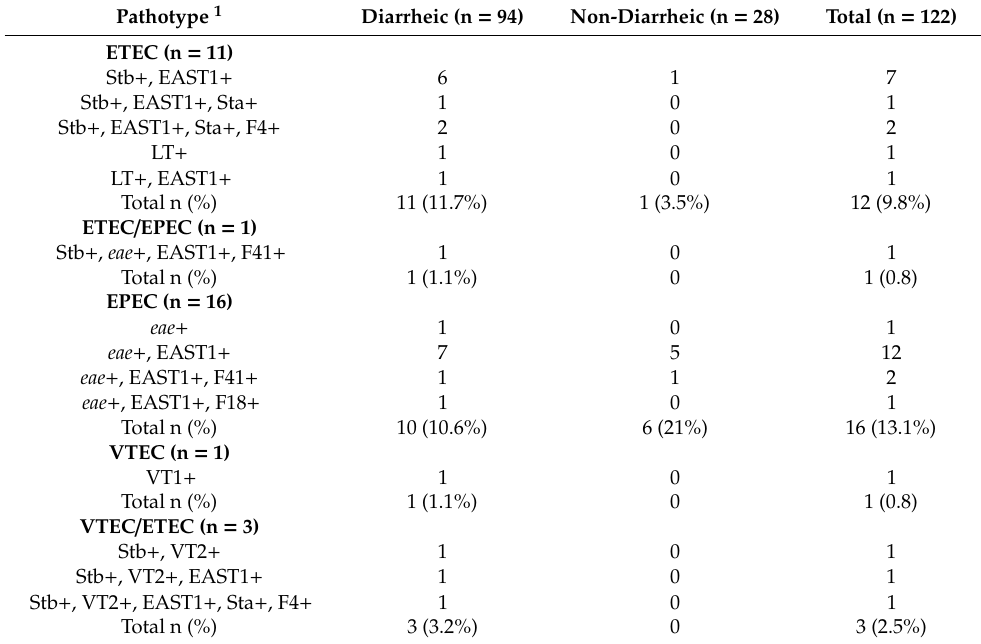
Table 3. Description of the profiles of virulence factor production and classification of the toxigenic strains into pathotypes of E. coli